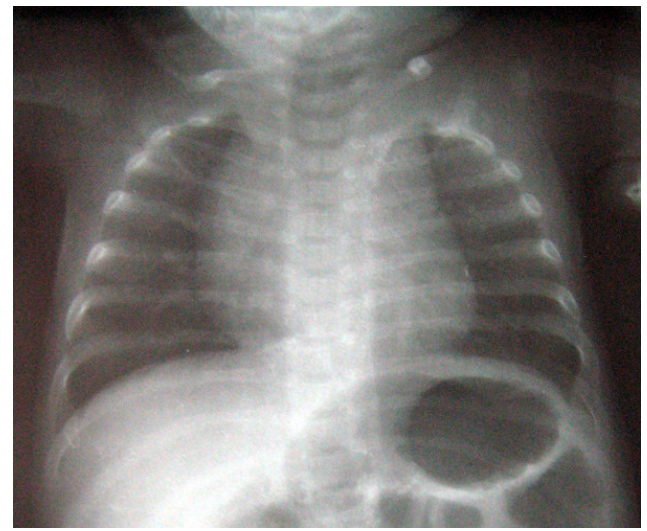
FIGURE 3. Chest X-ray at 2 months showing no pleural